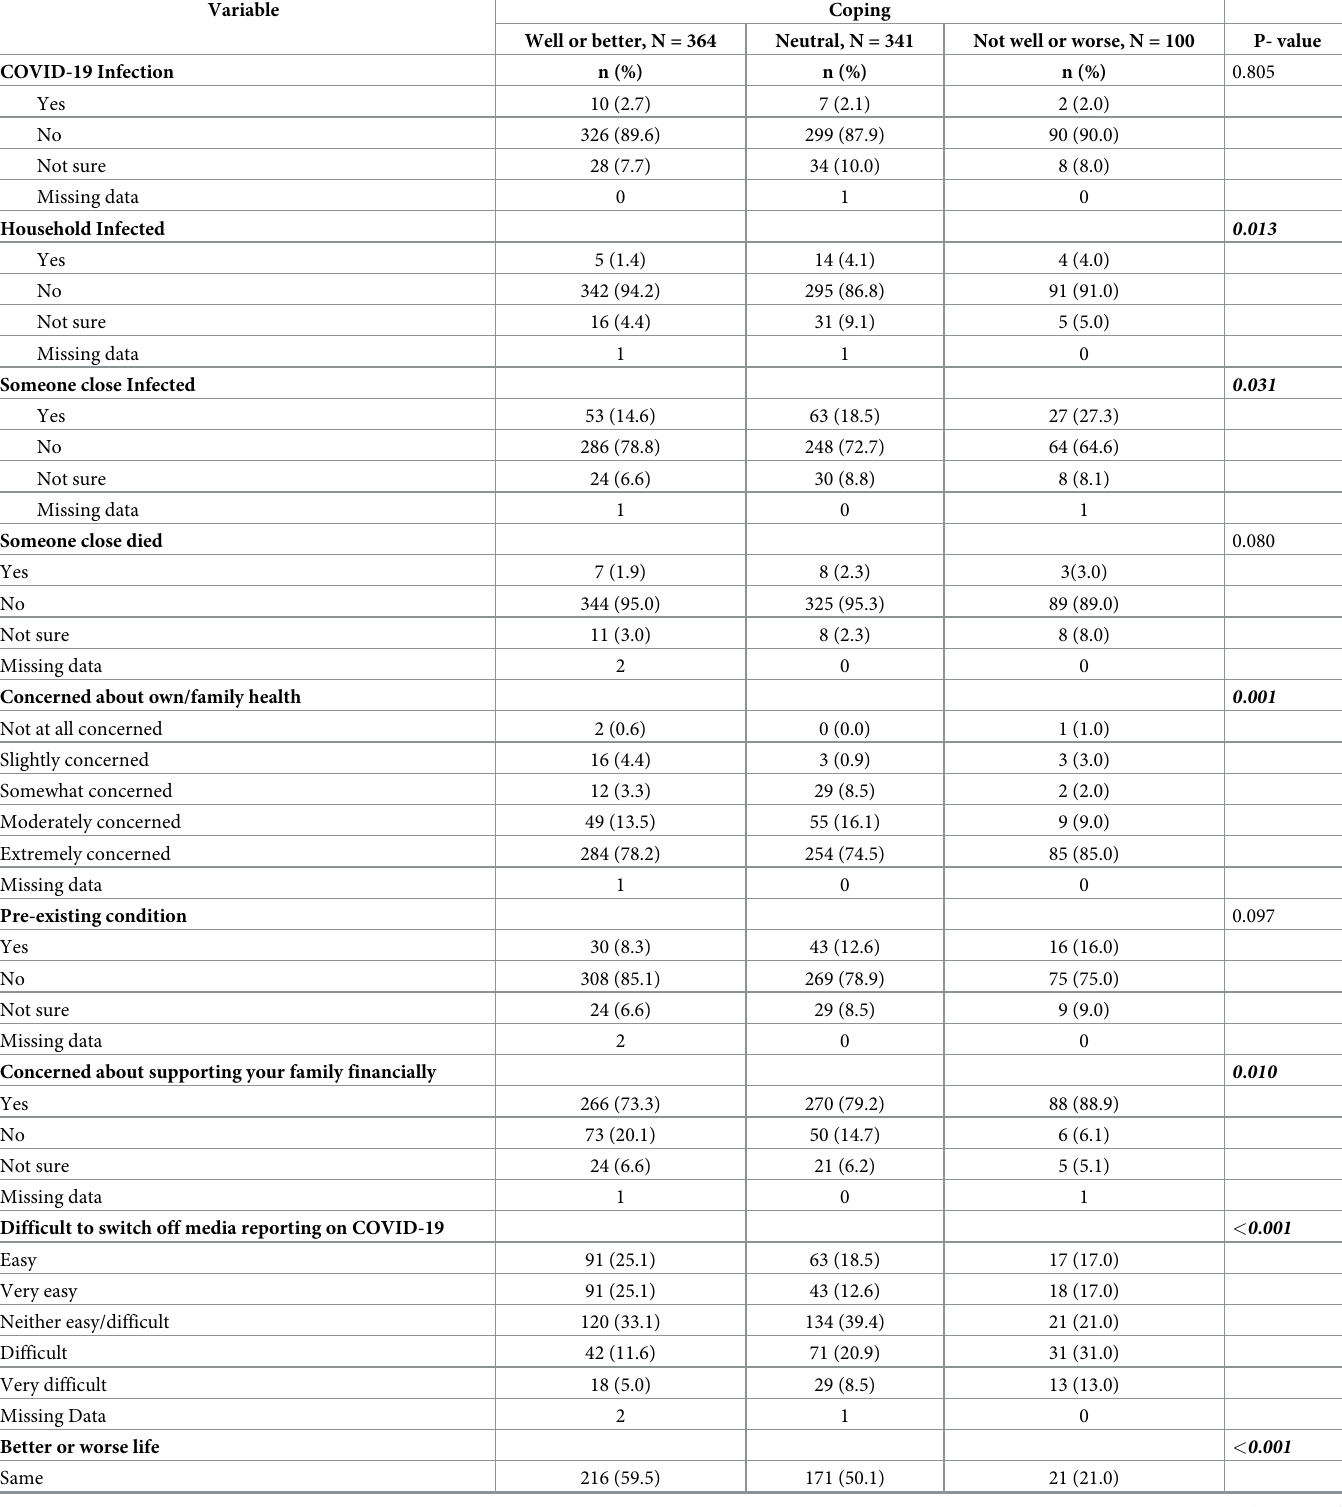
Table 5. Association between coping and COVID-19 related characteristics of